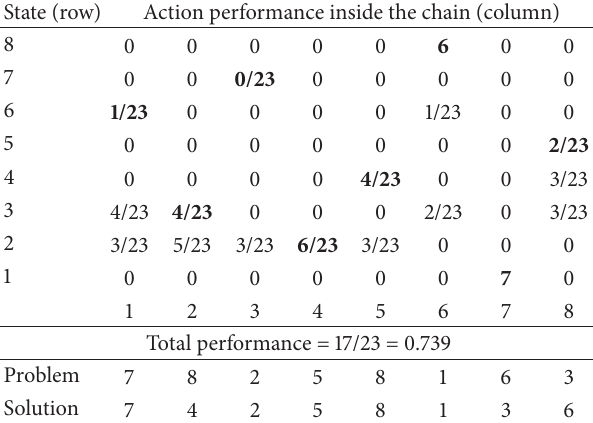
Table 3: LSPI case ( 1 ).